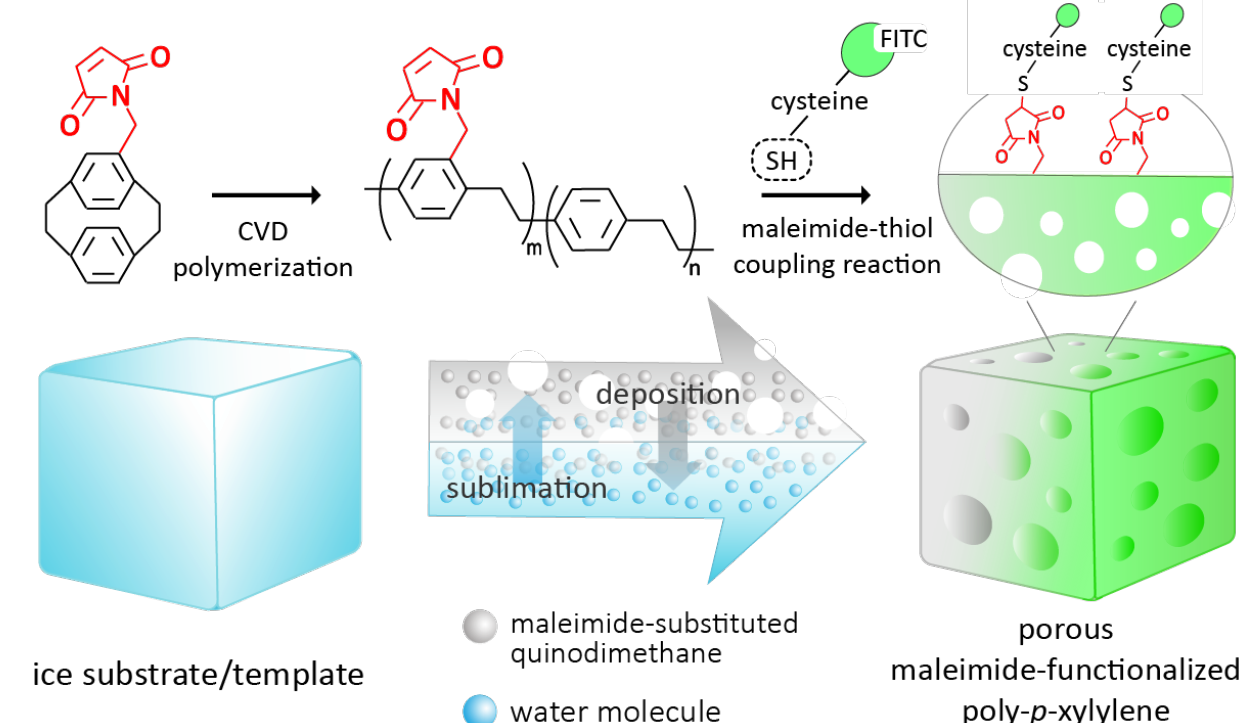
Figure 1. A schematic illustration of vapor-phase fabrication by chemical vapor deposition polymerization of 4-N-malei- midomethyl-[2,2]paracyclophane on a sublimating ice substrate/template to construct a porous and maleimide-function- alized poly -p- xylylene material. The resultant functional material exhibits interface chemical properties and is readily able to perform the maleimide-thiol click reaction under mild conditions.